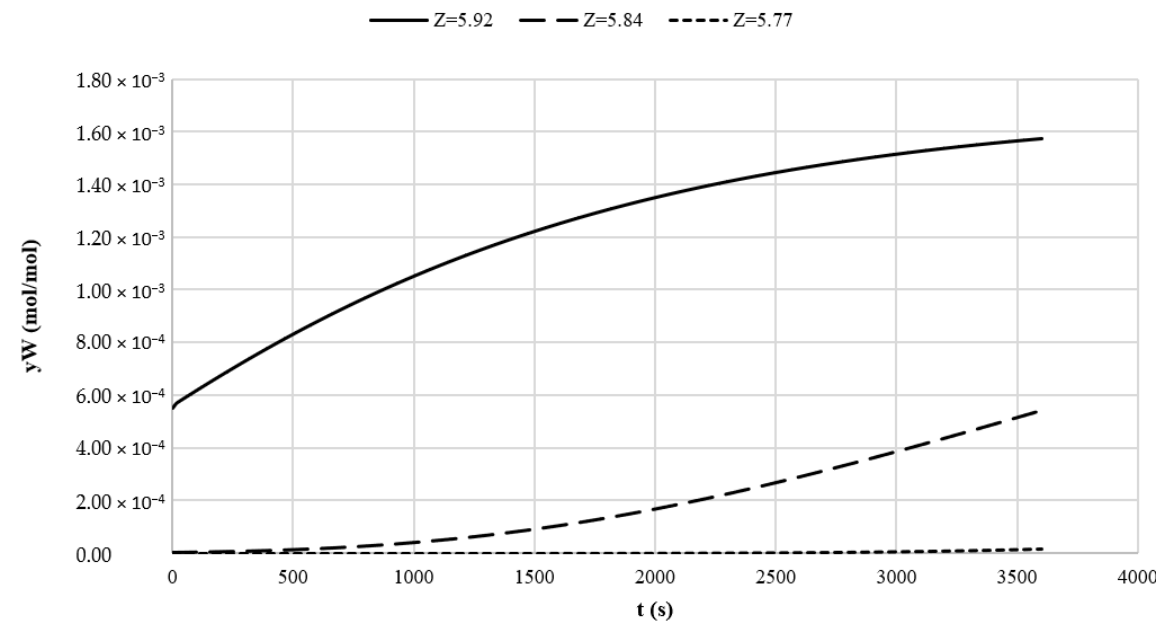
Figure 17. Water output mole fraction in three different zones of the bed.